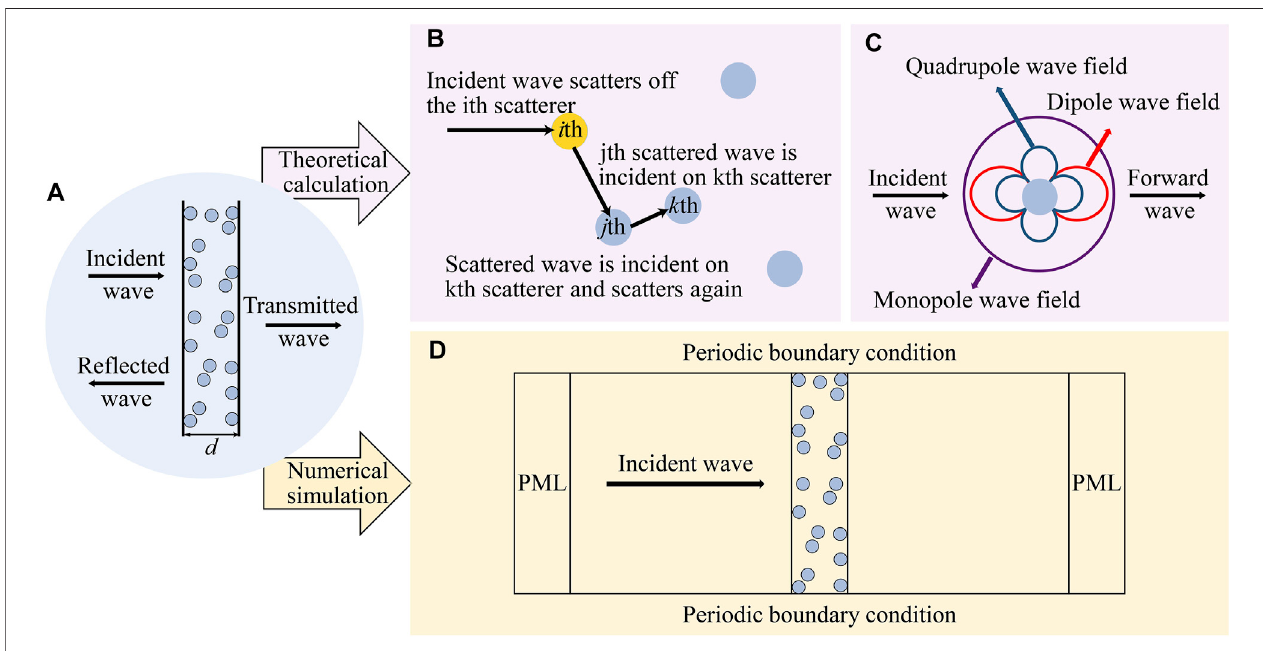
FIGURE 1 | (A) Random distribution of scatterers immersed in a fl uid matrix. (B) Schematic diagram demonstrating multiple scattering of the incident wave by several scatterers. (C) Monopole, dipole, and quadrupole resonances due to the mechanical contrast between a single scatterer and the fl uid matrix. (D) Schematic diagram showing the geometry and boundary conditions used in the numerical simulation FEM